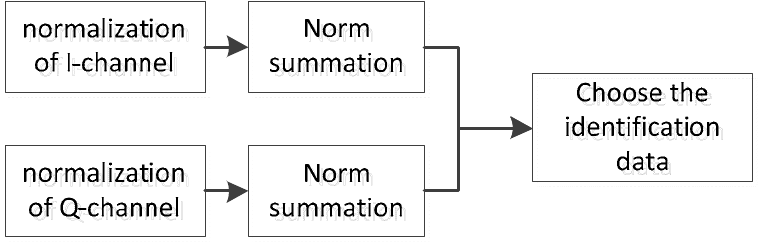
Figure 4. Extraction of identification data.